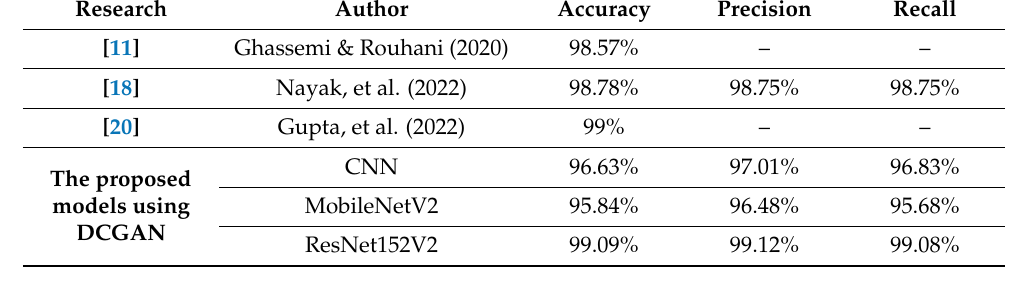
Figure 15. Accuracy, precision, recall, and area under the curve (AUC) measures for the proposed CNN, MobileNetV2, ResNet152V2 models using Vanilla GAN and DCGAN image generated. Table 8. Comparison with related works.